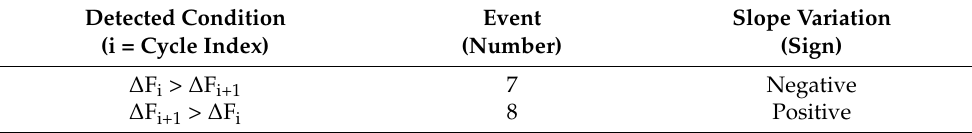
Table 2. Detection of the longitudinal slope based on GRF-vertical-component